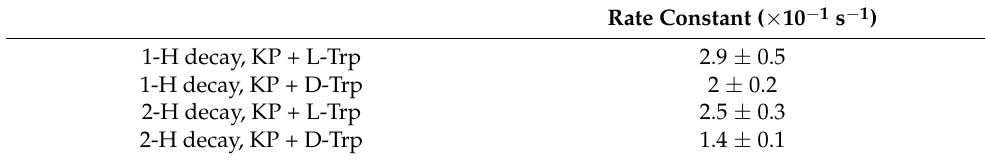
Table 2. Rate constants of the decay of 1-H and 2-H lipid signals under irradiation in DHPC/DLPC bicelles with KP and L/D-Trp, pH = 3.3.